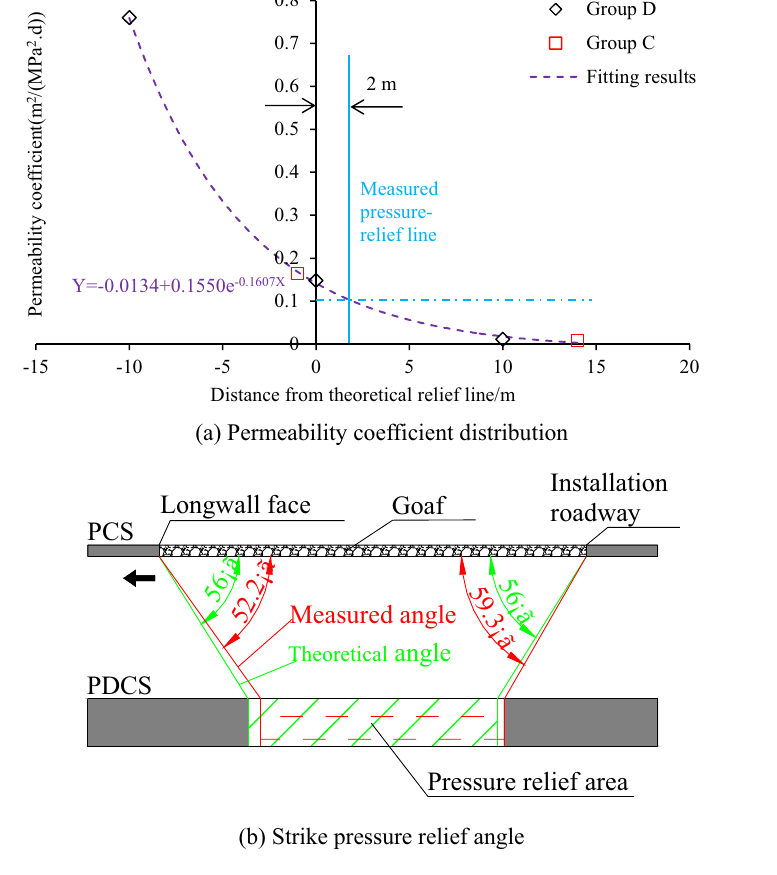
Figure 12. Strike pressure relief angle and its